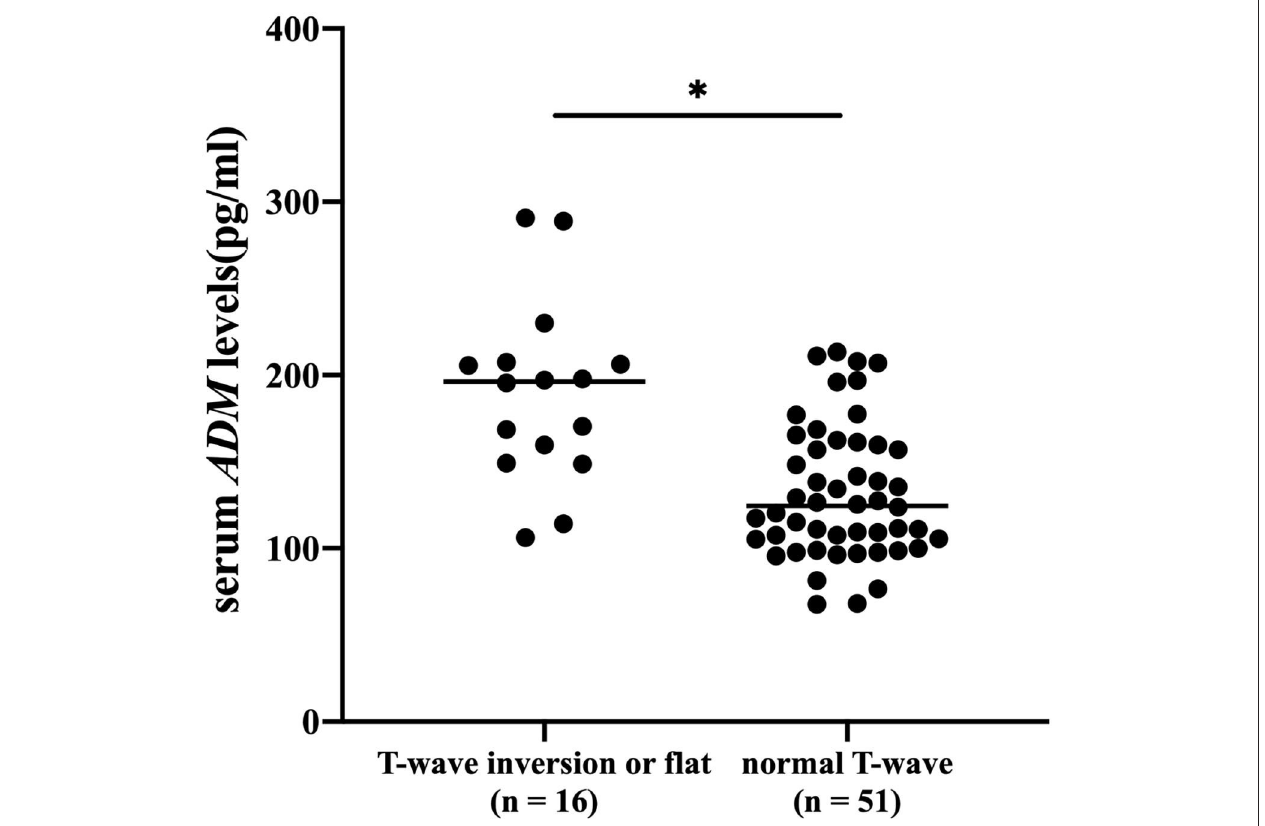
FIGURE 2 | Serum levels of adrenomedullin (ADM) (pg/ml) were measured in patients with lung cancer with or without T wave inversion or flattening. * p < 0.05.